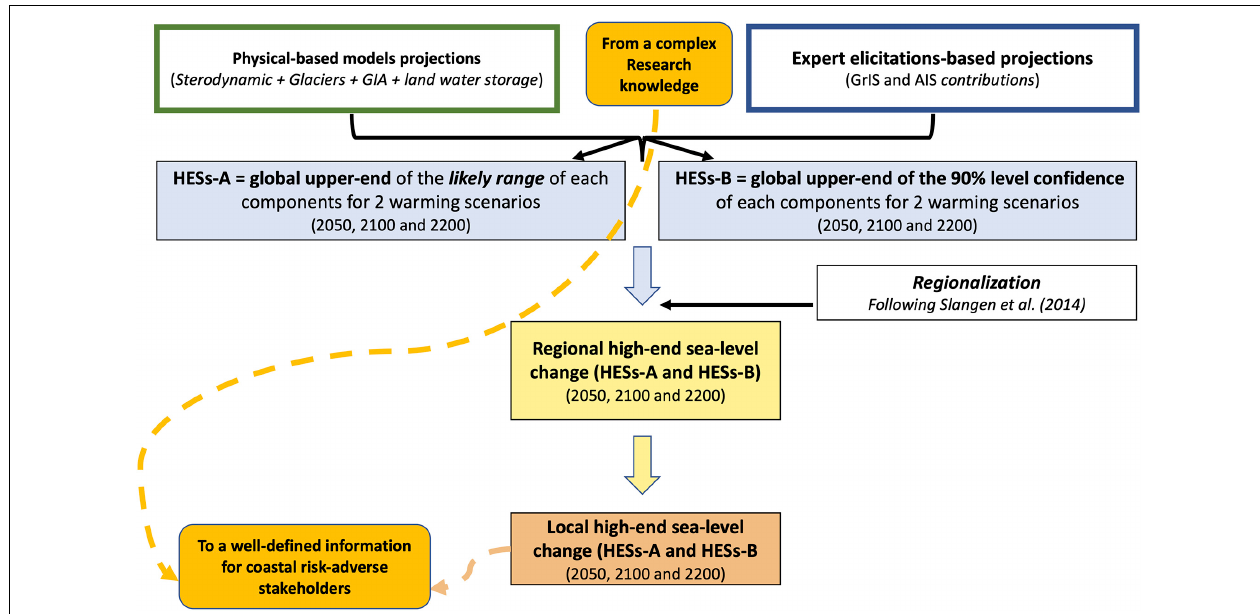
FIGURE 2 | Scheme of our general approach for assessing global to regional and local HESs. Blue boxes display high-end design choices that can be adjusted depending on user’s